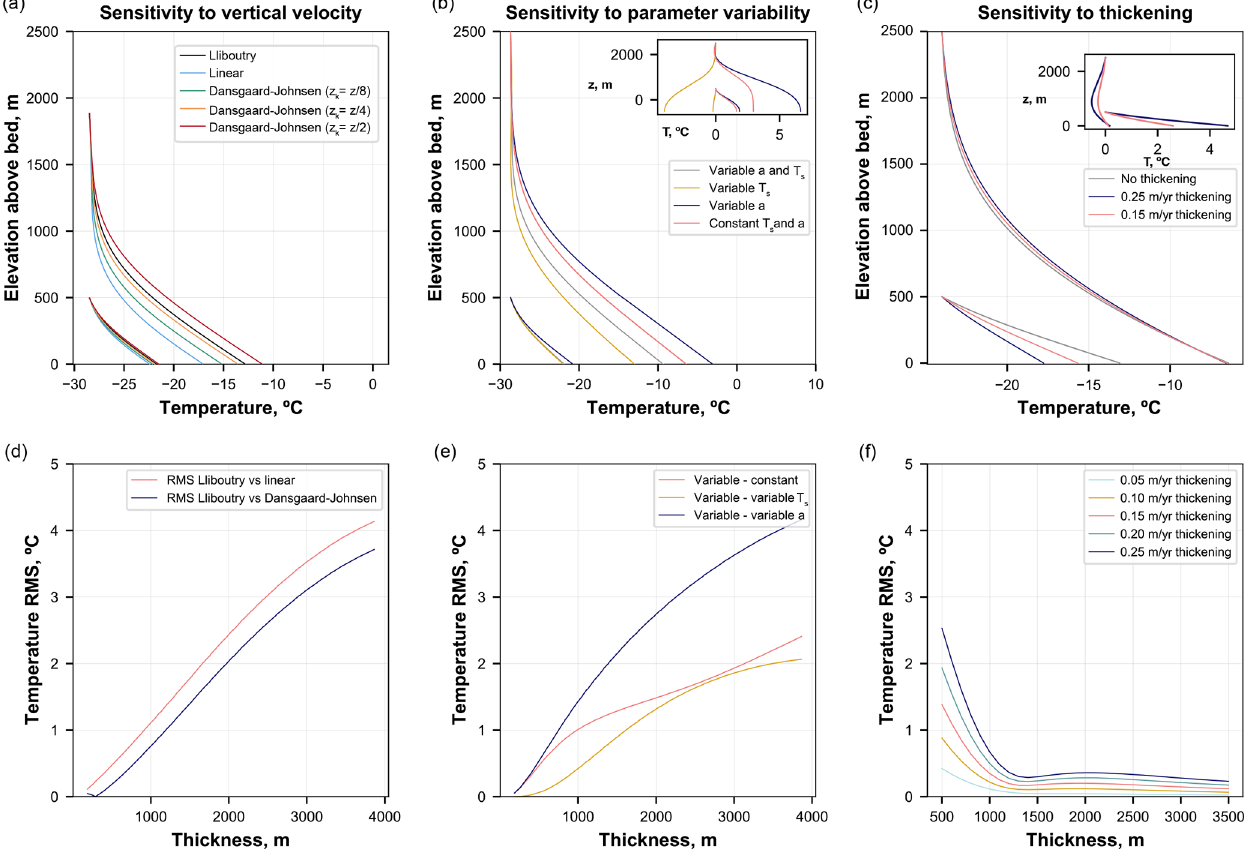
Figure 6. Englacial vertical temperature profile sensitivity to vertical velocity function and accumulation/surface temperature temporal variability. (a) Comparison of three temperature profiles obtained using a forward model for grounded ice with the Lliboutry, Dansgaard– Johnsen (with different values of “kink height” parameter z k ) and linear-vertical velocity approximations. (b) Comparison of four temperature profiles obtained using forward model for grounded ice with and without temporal variability of surface temperature and accumulation. (c) Comparison of three temperature profiles obtained using a forward model for grounded ice assuming three different thickening rates. (d, e, f) Results of forward simulations showing how much a range of ice-thicknesses temperature profiles differ depending on (d) various vertical velocity models, (e) temporally variable and constant parameters, and (f) ice thickening